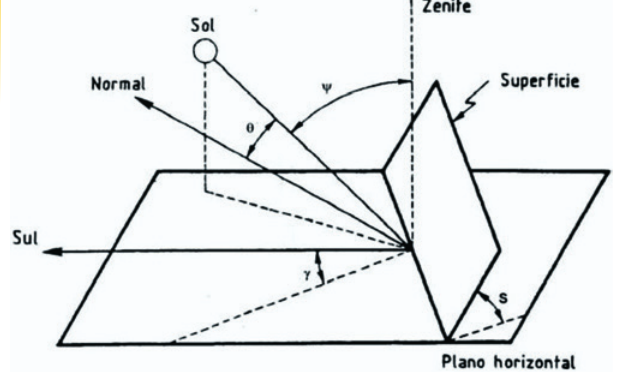
Incidência de raios solares em superfície